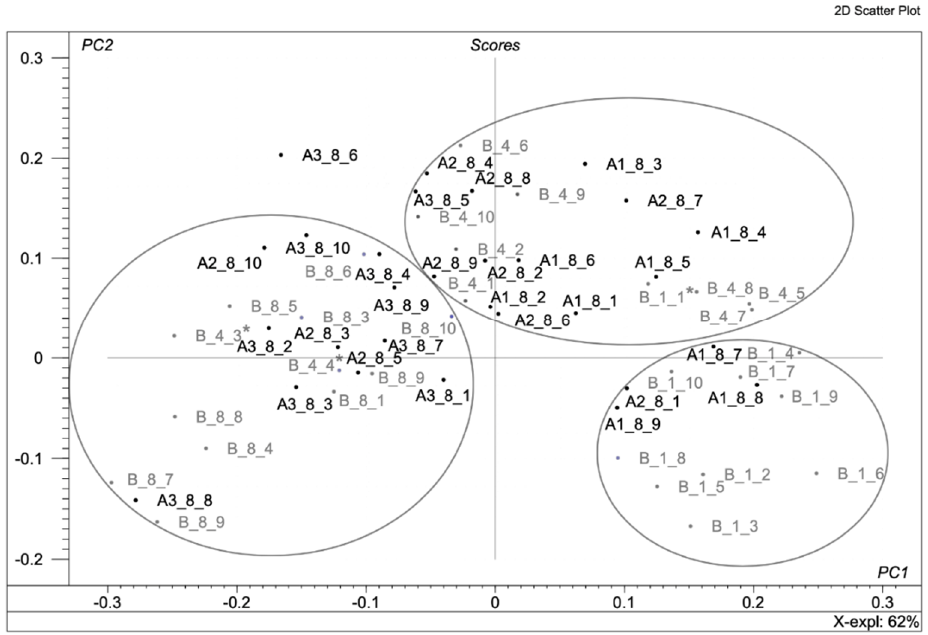
Figure 5. Oxidation pattern corresponding to active samples A1, A2 and A3 by means of principal component analysis (PCA).